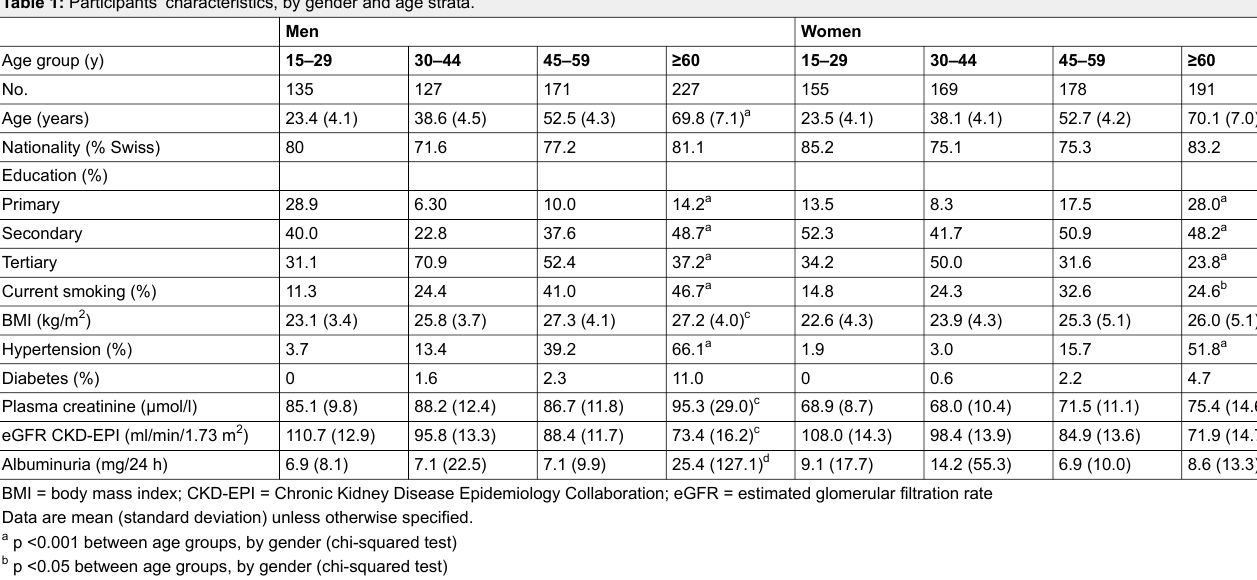
Table 1: Participants’ characteristics, by gender and age